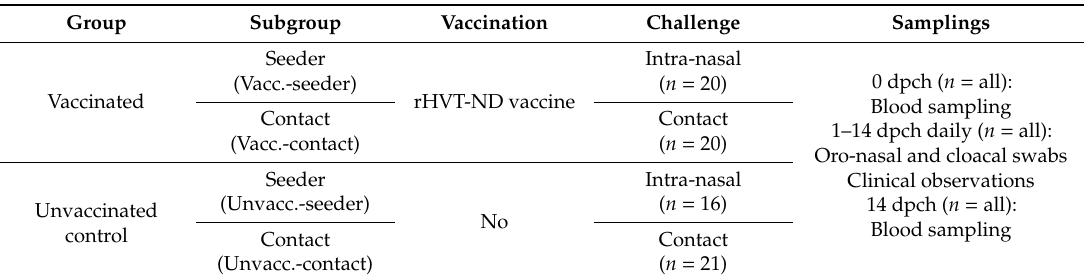
Table 1. Study design to quantify the e ff ect of a turkey herepesvirus vector-based vaccine on the transmission of Newcastle disease virus in